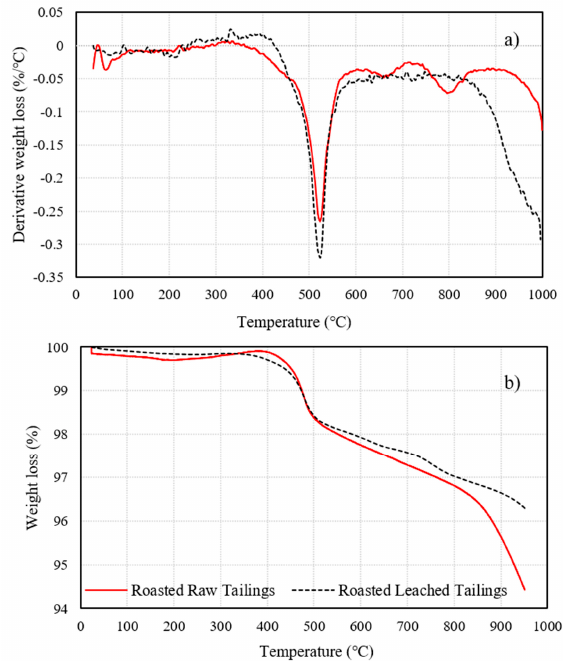
Figure 4. Di ff erential thermogravimetric ( a ) and thermogravimetric ( b ) graphs of roasted Figure 4. Differential thermogravimetric ( a ) and thermogravimetric ( b ) graphs of roasted tailings.